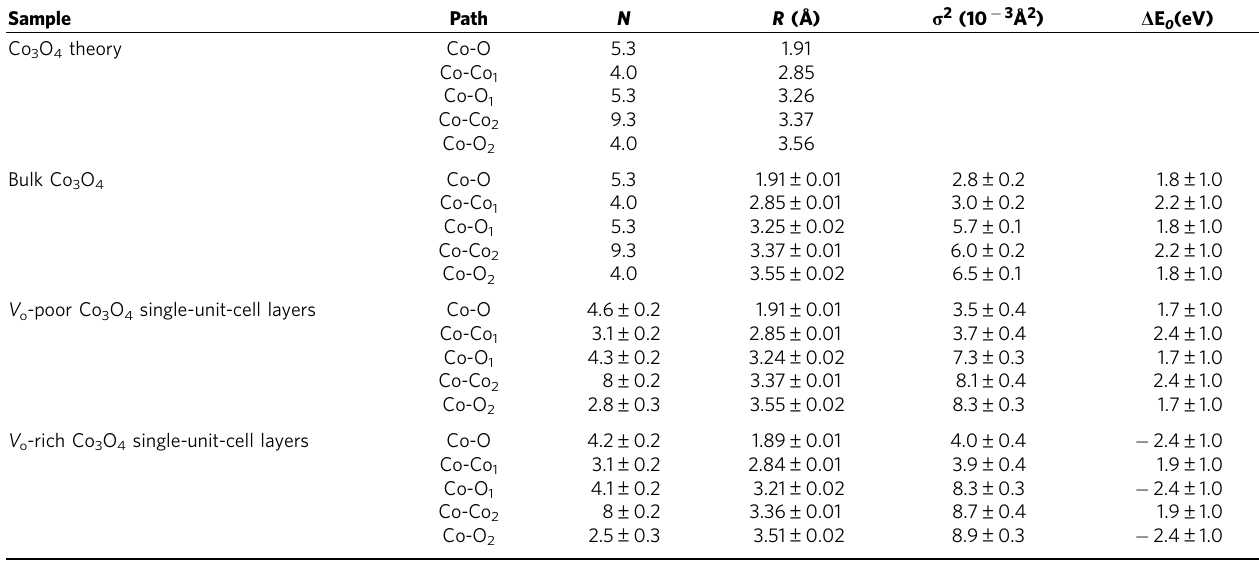
Table 1 | EXAFS curve-fitting results.